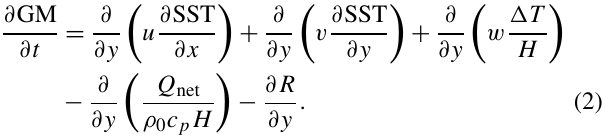
the bottom of the mixed layer. H is mixed-layer depth. Q